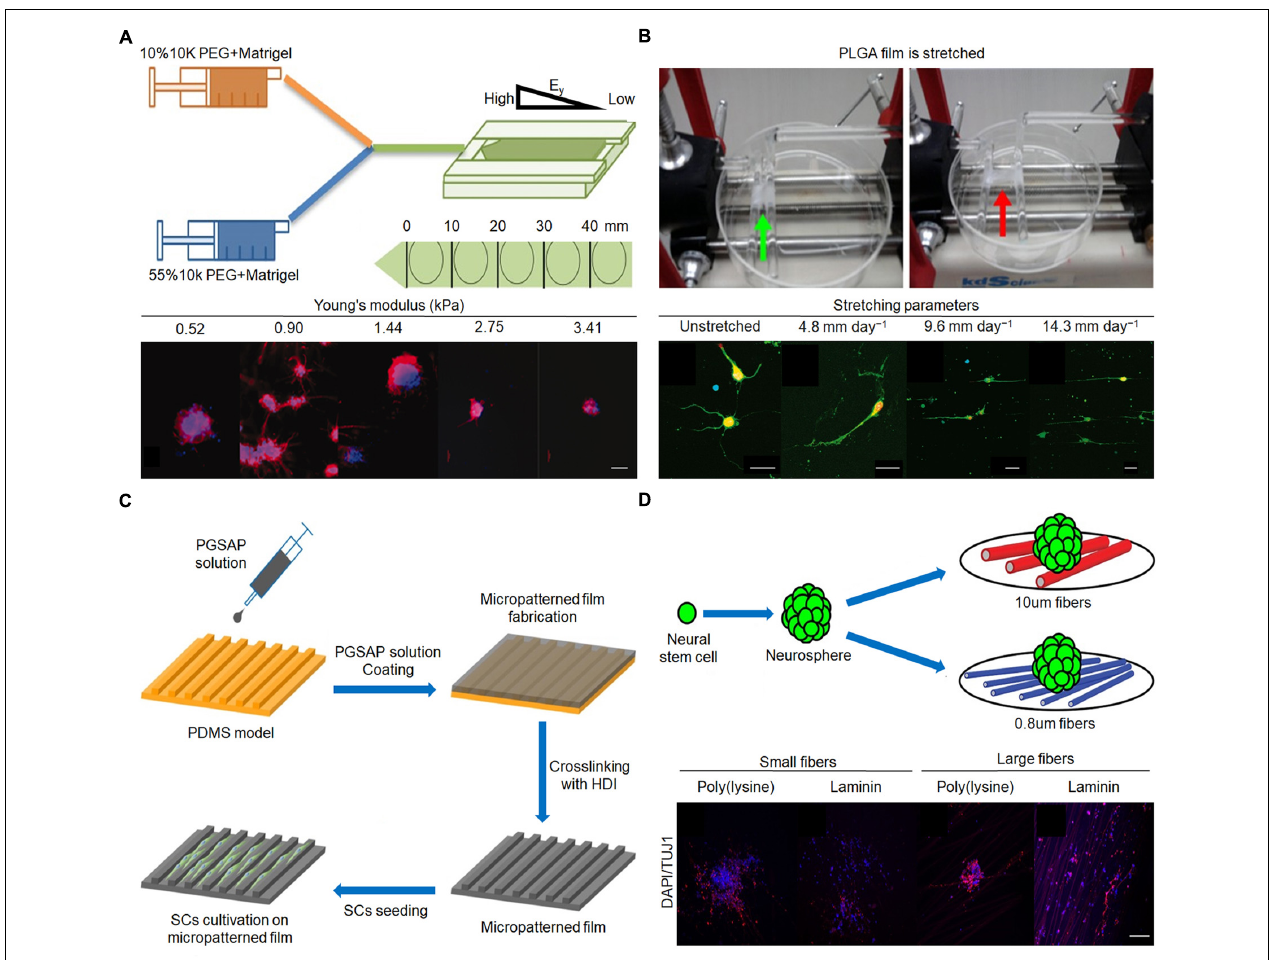
FIGURE 3 | Effect of stiffness, mechanical tension, and 2D terrain on behaviors of nerve cells. (A) Fabrication procedure of gradient hydrogel. Immunofluorescent staining of tubulin III (red) and nucleus (blue) in human neural stem cell (hNSC) after 14 days for culture on PEG hydrogel possessing a continuous gradient in Young’s modulus (Mosley et al., 2017). Scale bar = 100 µ m. (B) Poly(lactic- co -glycolic acid) (PLGA) film is stretched by the control system. Immunofluorescence staining of neurons after 3 days in vitro on upstretched film and films stretched at 4.8, 9.6, and 14.3 mm day − 1 (Feng et al., 2016). Scale bar = 50 µ m in all images. (C) Micropatterned film preparation and Schwann cell cultivation (Wu et al., 2018). (D) Mouse E13 NSCs were plated onto poly( ε -caprolactone) (PCL) fiber mat. Immunofluorescent staining of nerve cells on different diameters (Czeisler et al., 2016). Scale bar = 100 µ m. Figures reproduced with permission from the references